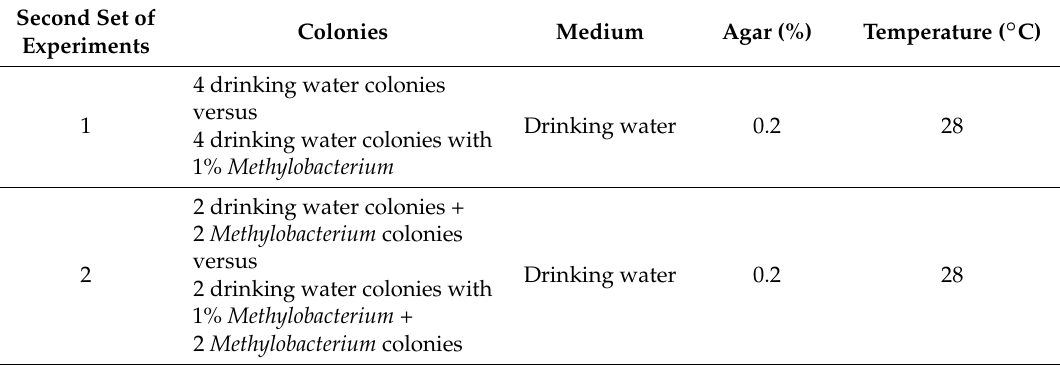
Table 2. Summary of conditions of the second set of